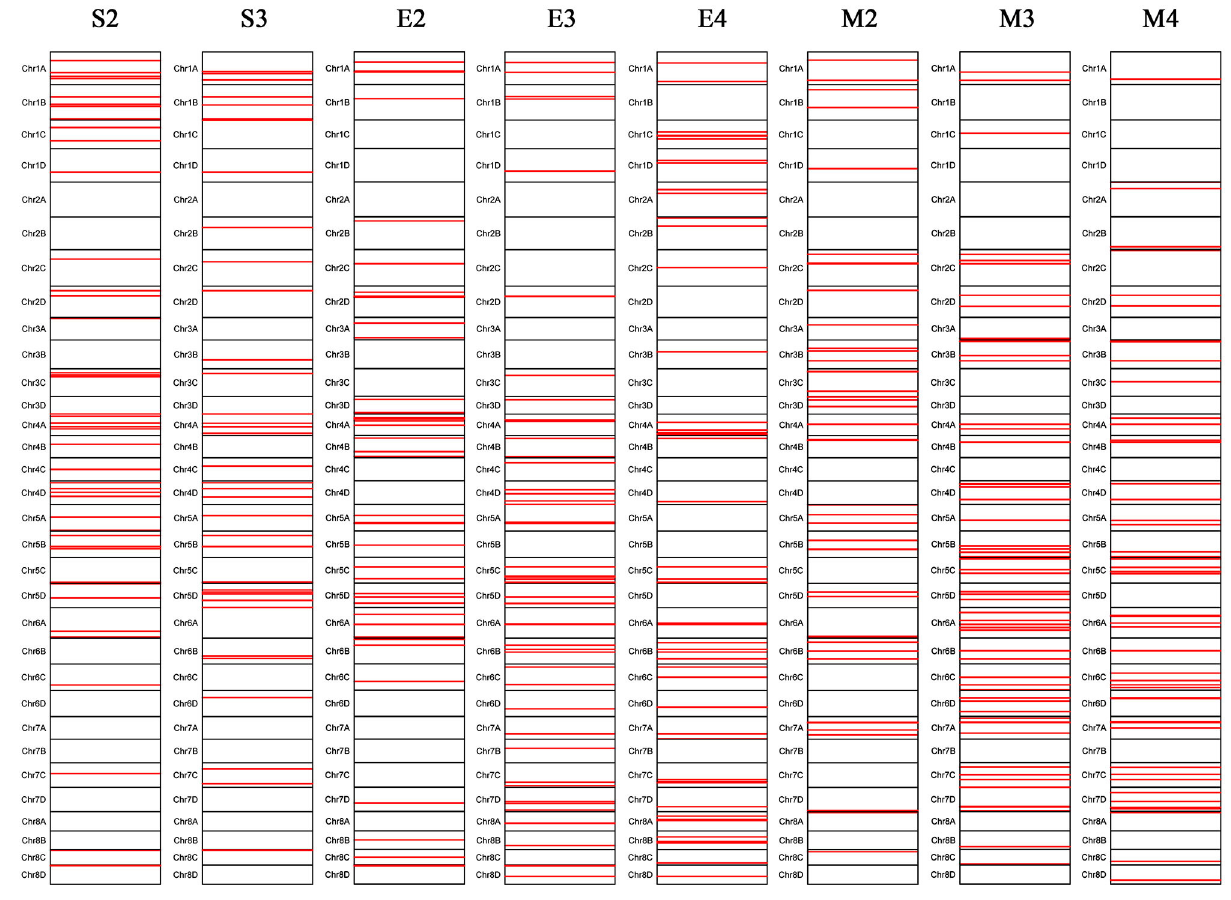
FIGURE 5 | Chromosomal locations of the leaf angle loci mapped in sugarcane three growth stages. S2 and S3 denote the + 2 and + 3 leaf of the sugarcane seedling stage, respectively; E2, E3, and E4 denote the + 2, + 3, and + 4 leaf of the sugarcane elongation stage, respectively; M2, M3, and M4 denote the + 2, + 3, and + 4 leaf of the sugarcane mature stage,